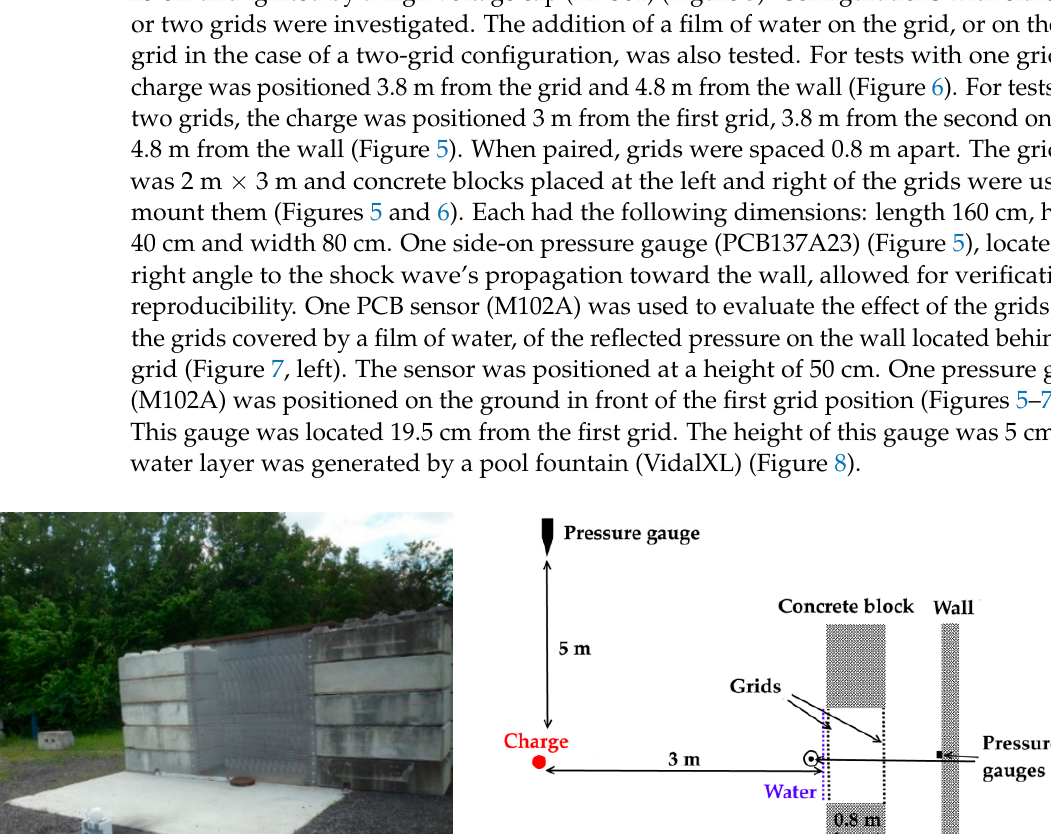
Figure 4. View of the EDST end showing the panel in the background, the piece of retroreflective material plastered on the wall and the 45-degree inclined mirror.